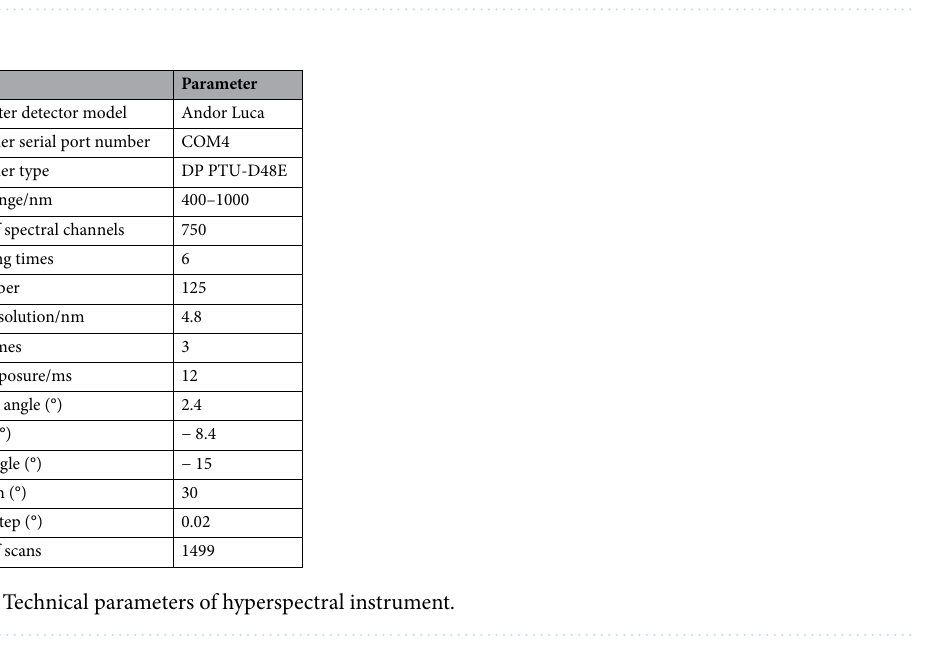
Table 1. Samples information for Grass1 dataset.